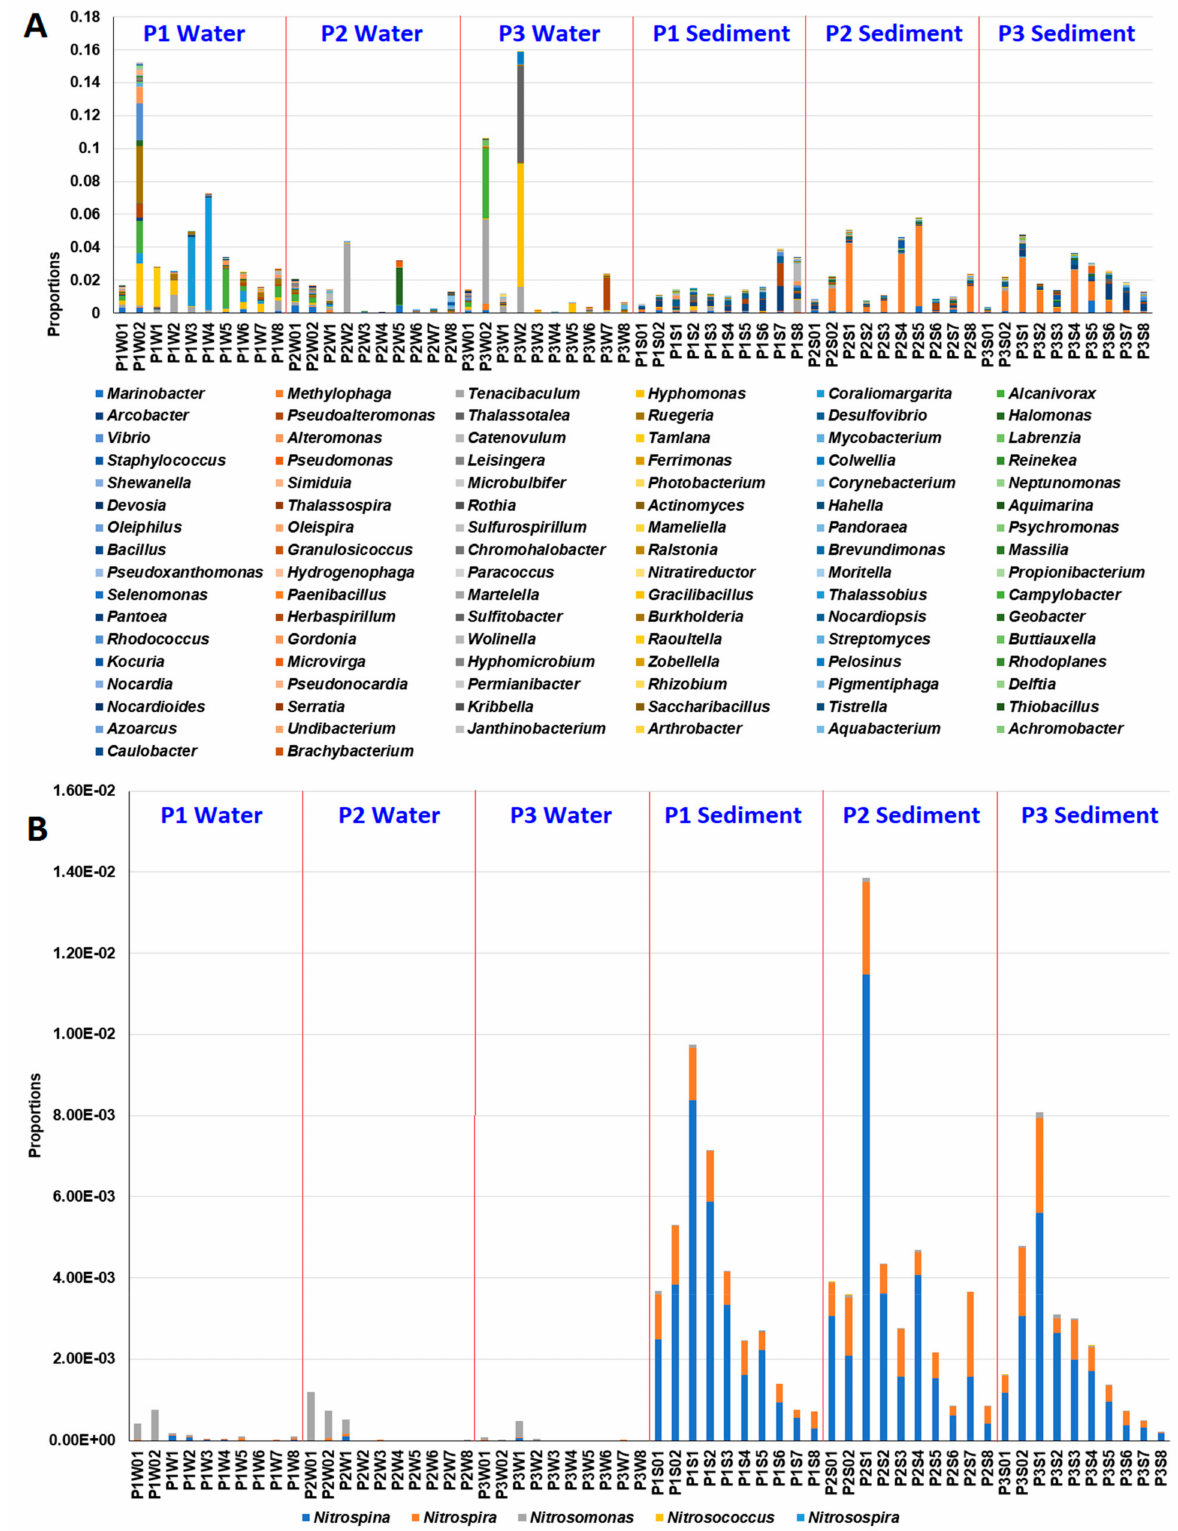
Figure 6. Proportions of dissimilatory nitrate reduction (nitrate => ammonia) ( A ) and nitrification (ammonia => nitrite) ( B ) associated microbial communities among the water and sediment of small milkfish ponds. P1: control small milkfish pond. P2: small milkfish pond with the addition of MG. P3: small milkfish pond with the addition of MG and MG- degrading